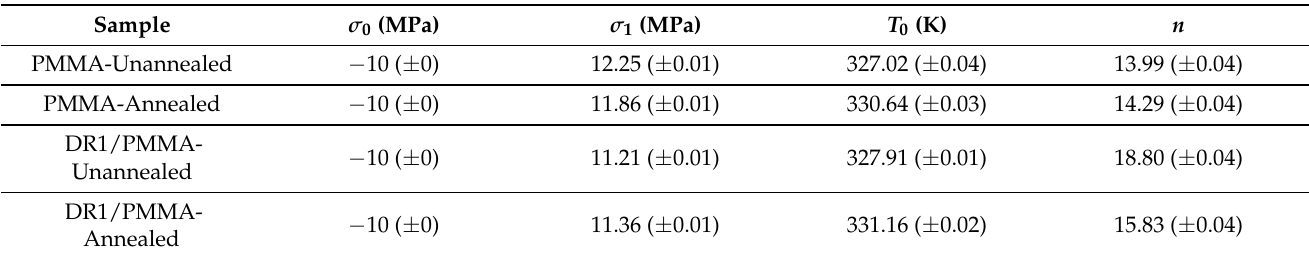
Table 5. The parameters determined from fitting the temperature-dependent stress data in Figure 6 to Equation